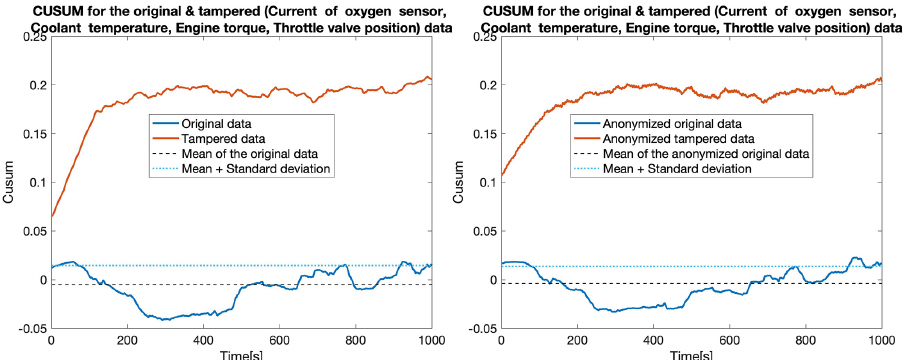
Figure 14. CUSUM for the original data (blue) and tampered data (orange) for four sensors